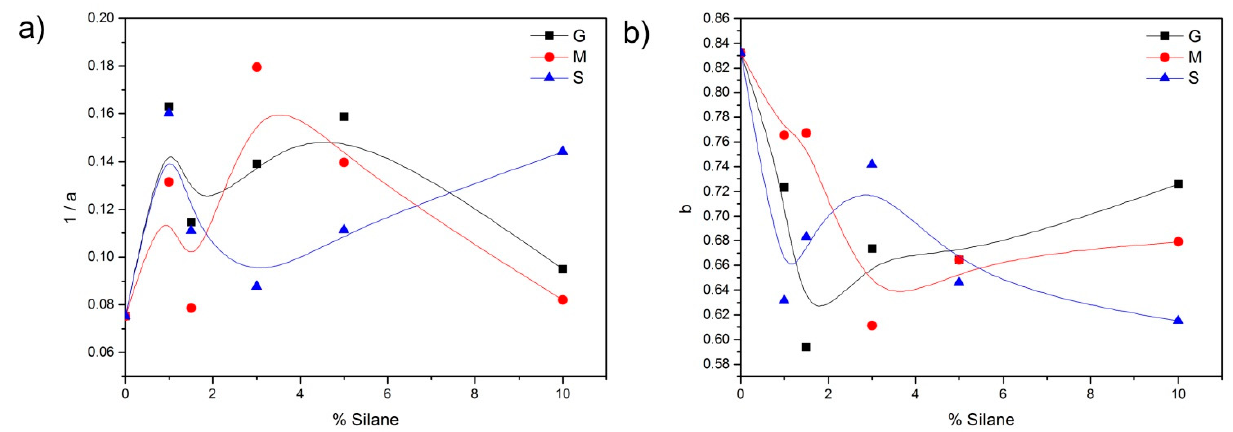
Figure 10. ( a ) Weibull kinetic parameter k (1/a) as a function of the silane concentration, and ( b ) Weibull transport parameter b as a function of the silane concentration.